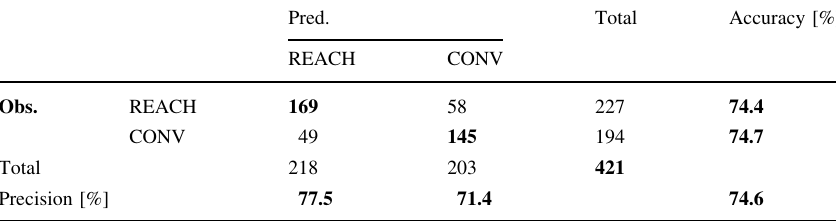
Table 19 Classification quality of the classification tree method after merging Pred.